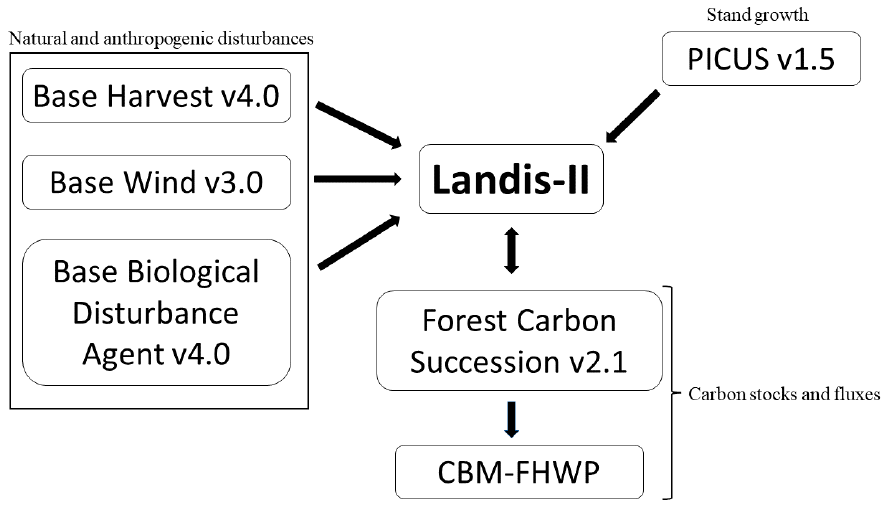
Figure 2. Modelling framework used in this study.